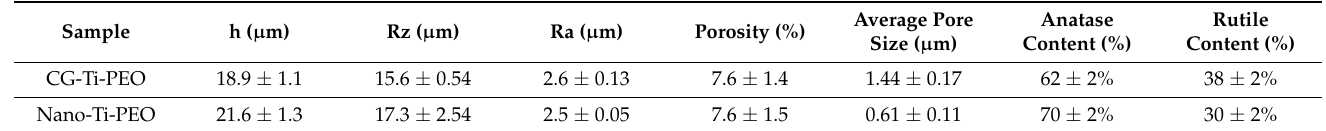
Figure 2. SEM images of the top view of the PEO coatings on CG-Ti ( a ), nano-Ti ( b ). Table 2. Properties of the PEO coatings on coarse-grained and nanostructured Ti disks.